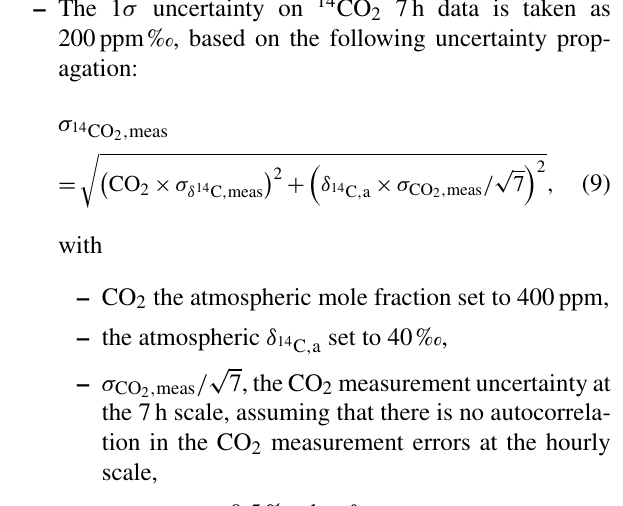
Figure 7. Ground-based 14 CO 2 and CO 2 observation networks. A total of 113 stations located following the scenario proposed by Marshall et al. (2019), based on real or potential observation net- works (ICOS, NOAA, GAW, more details in Sect.